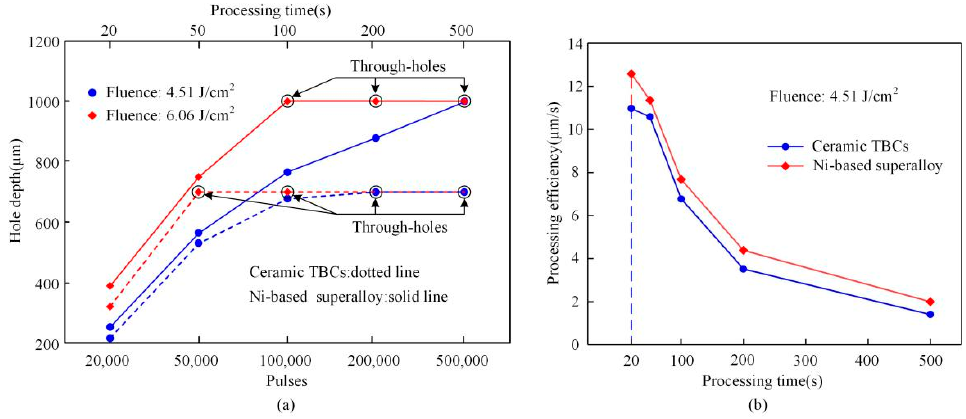
Figure 7. Holes depths and processing efficiency in ceramic TBCs and the Ni-based superalloy ( a ): Hole depth versus pulses ( b ): Processing efficiency versus time.